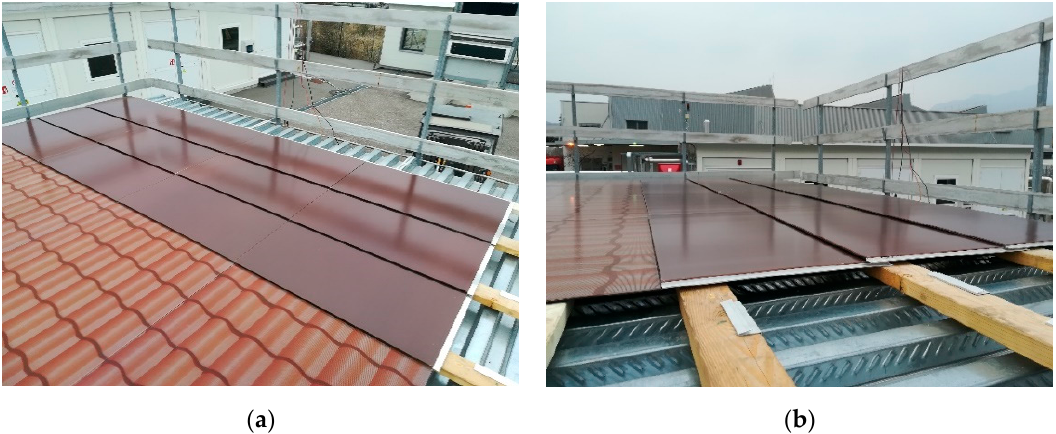
Figure 10. Testbed realisation on the outdoor roof testbed. To perform quantitative tests, the two module types Suncol ® Terracotta and Suncol ® Texturing Roof Tile are connected in two strings to a multi-string (two maximum power point trackers) grid-connected inverter. PT100 temperature sensors are applied on the backside of eight modules, as displayed in Figure 10b.